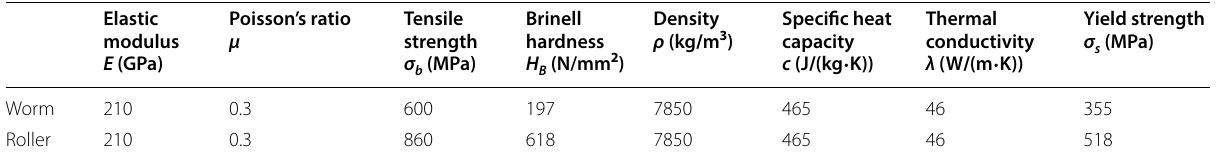
Table 3 worm and roller material parameters